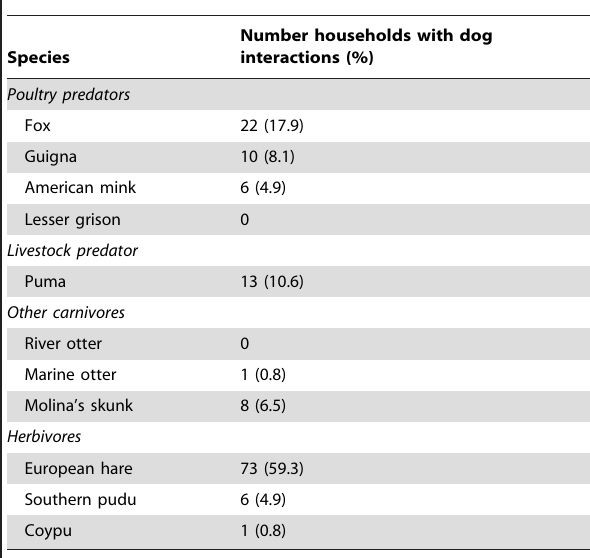
Table 2. Dog-wildlife interactions reported by dog owners.